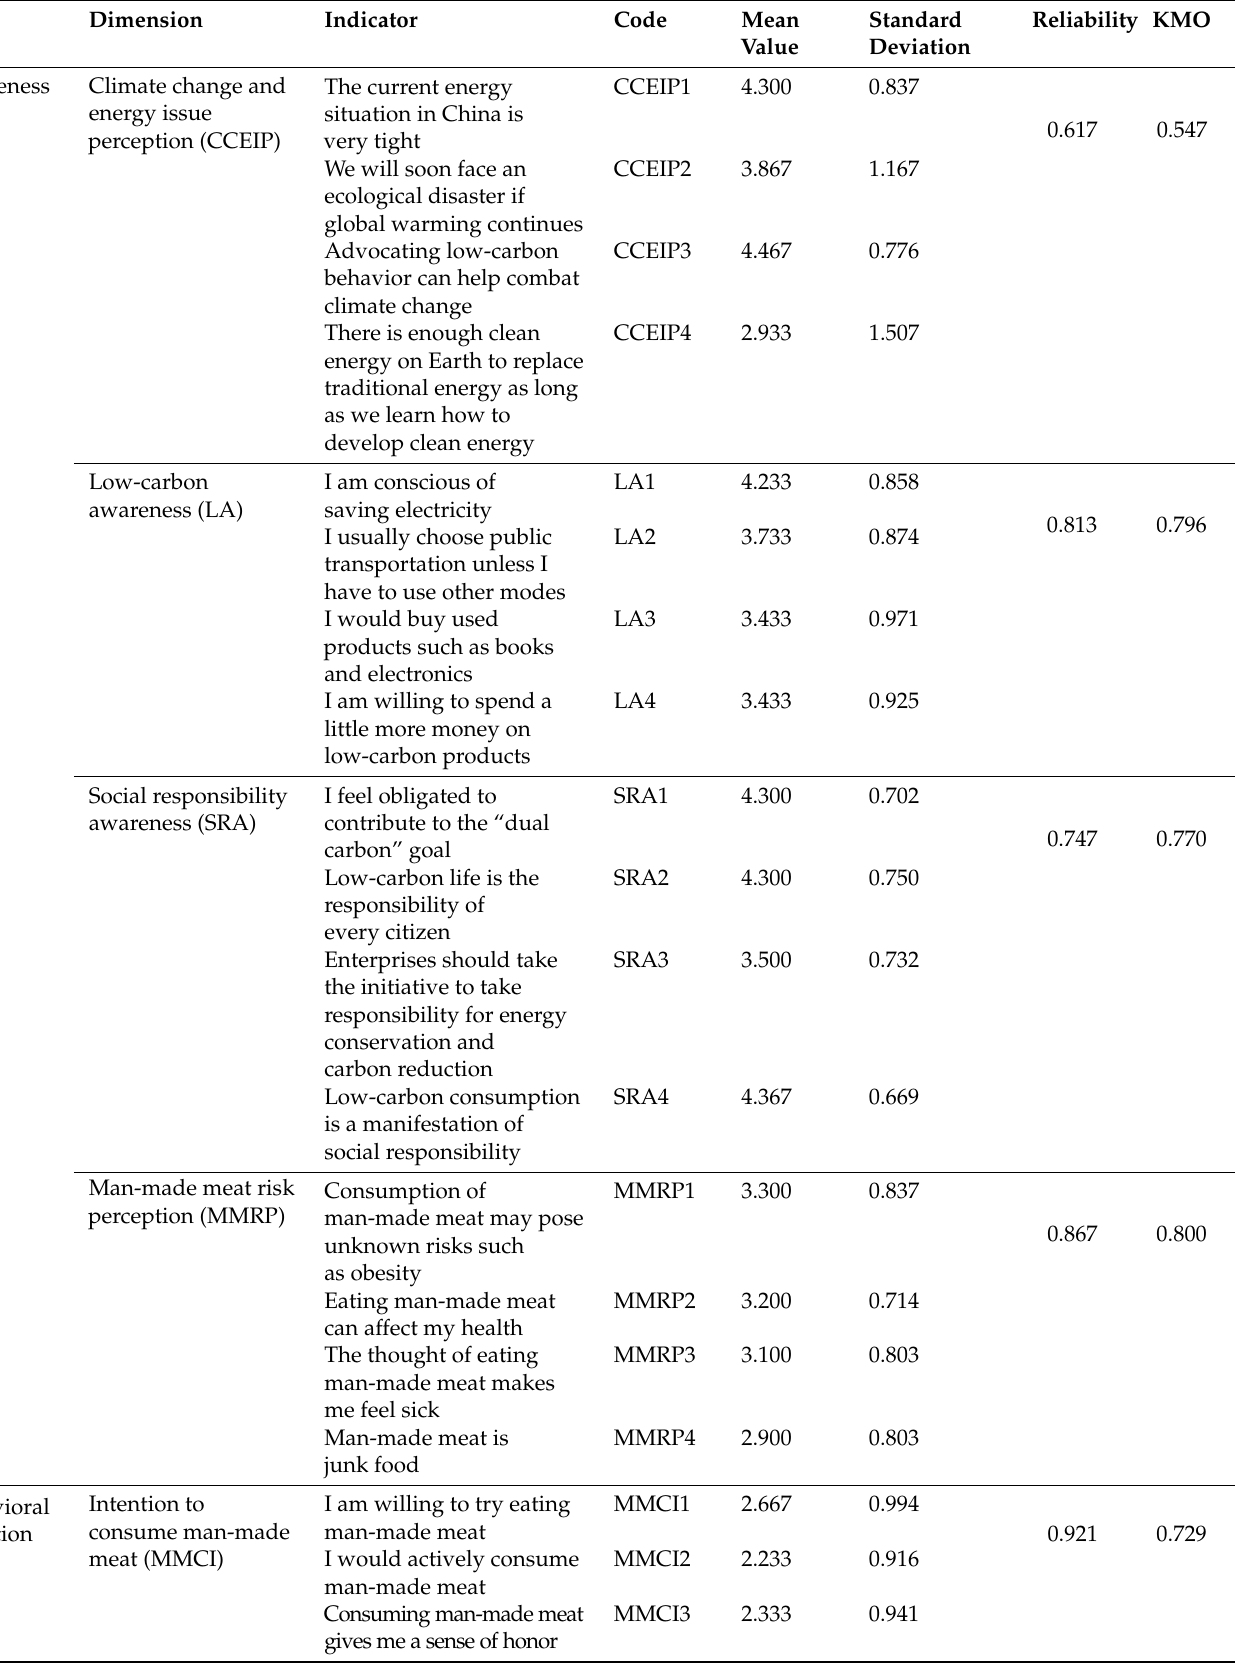
Table 1. The indicator system of factors influencing the public’s intention to accept man-made